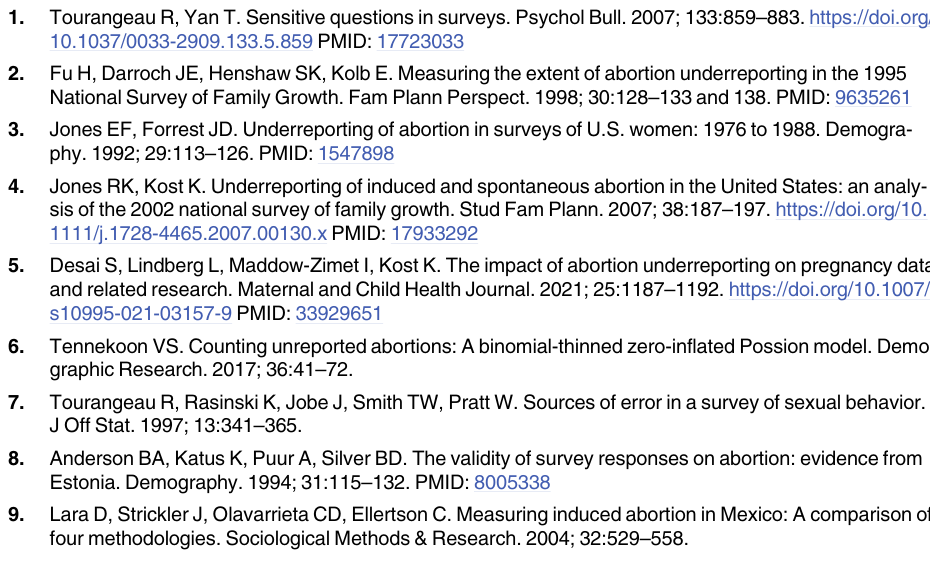
S2 Table. Question wording and factor loading for items in the attitudes toward marriage